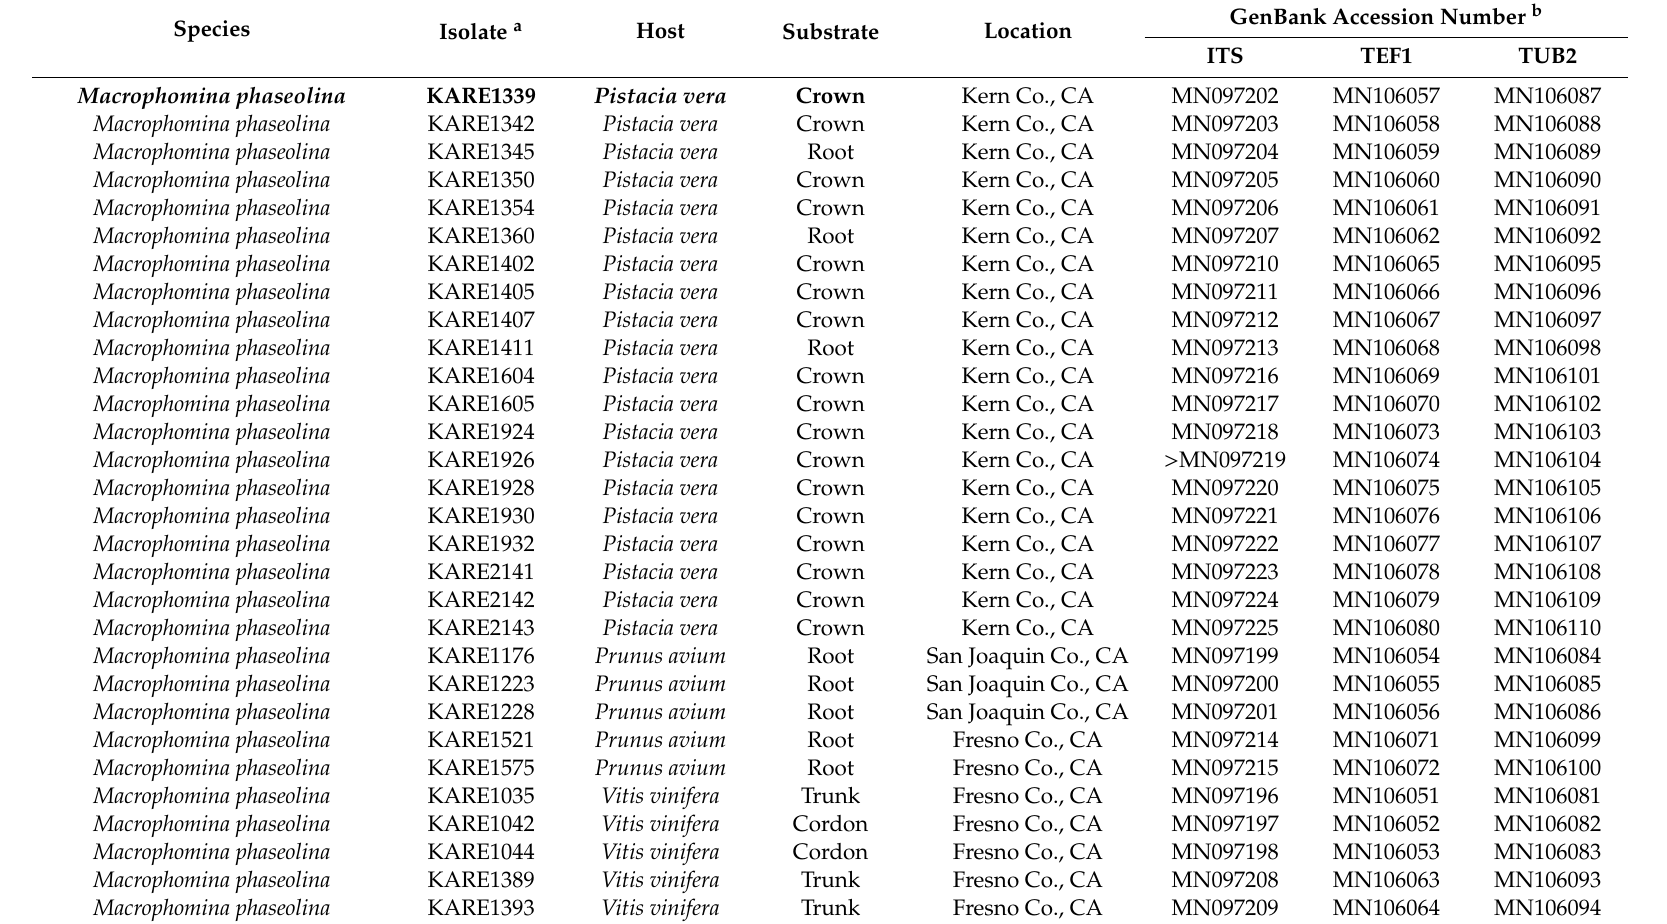
Table 1. Fungal isolates recovered in this